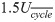
Columns from left to right: Iso-surface of the velocity magnitude at 1.5Ucycle¯, streamlines, vortex lines, and the measurement phase.Five measurement phases from top to bottom rows are early systole, systolic peak, late systole, dicrotic notch, and late diastole, respectively. Streamlines are colored by the normalized velocity magnitude (Umag/Ucycle¯), and vortex lines are colored by the normalized vorticity magnitude (ωmagD/Ucycle¯).